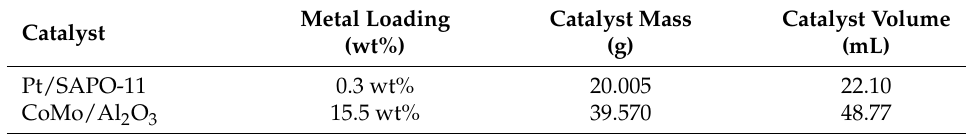
Table 1. Catalysts used during the experimental